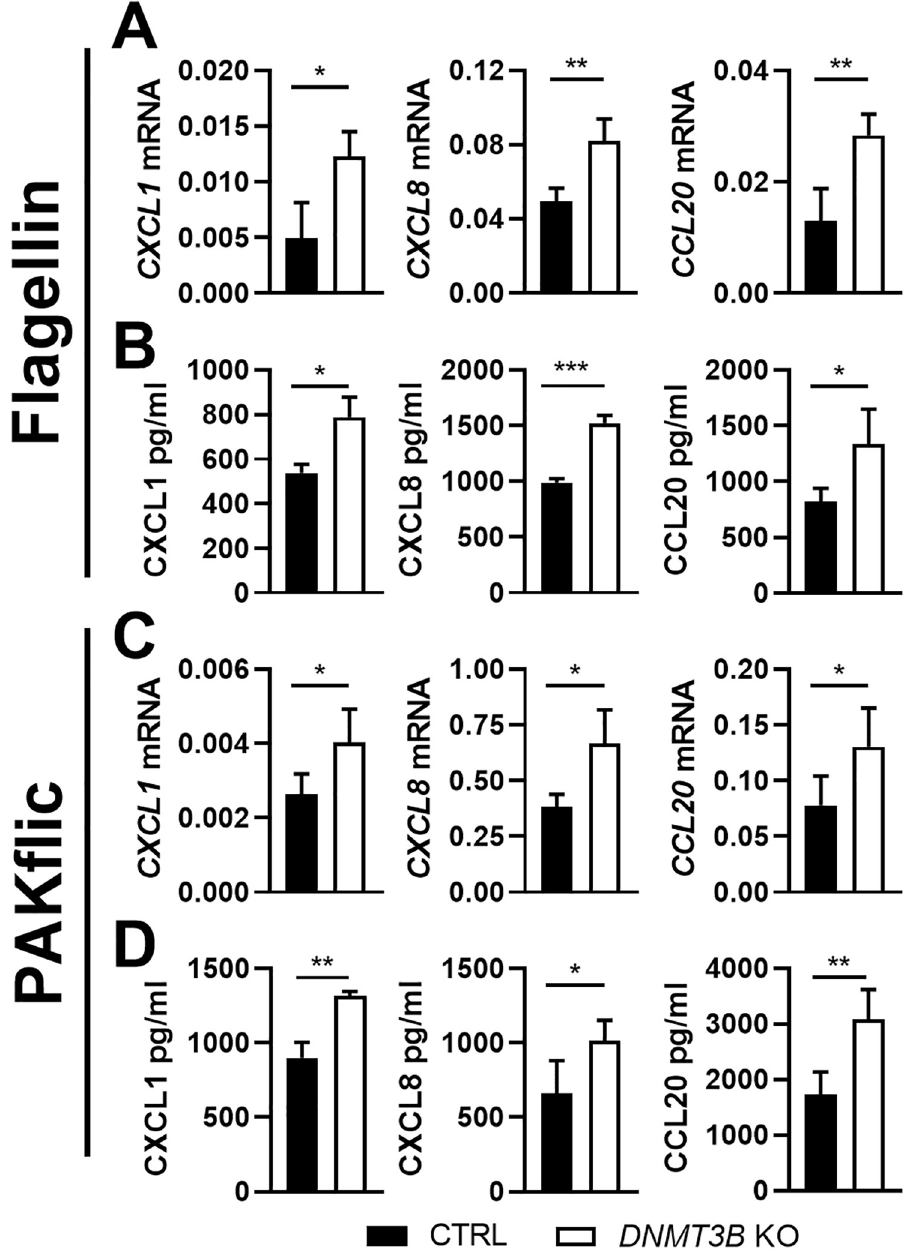
Fig 2. Dnmt3b deficiency in BEAS-2B bronchial epithelial cells promotes Pseudomonas aeruginosa induced chemokine production in vitro independent of flagellin. Dnmt3b deficient (knock out, DNMT3B KO; open bars) and control BEAS-2B cells (black bars) were stimulated with flagellin at final contrition of 1 μ g/ml (panels A and B) or heat-killed flagellin-deficient PAK (PAKflic, MOI = 50, panels C and D) for 12 hours. CXCL1 , CXCL8 and CCL20 mRNA levels were measured by RT-qPCR (A, C) and corresponding protein levels in supernatants by ELISA (B, D). Data are expressed as the mean ± SEM (n = 4) and representative of two to three independent experiments and for two DNMT3B KO and control clones. � p < 0.05, �� p < 0.01, ��� p < 0.001.